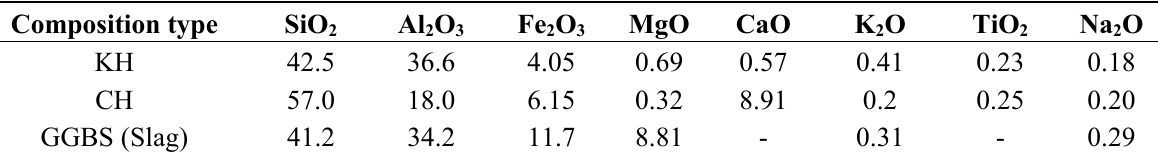
Table 1. Chemical composition of Hwangtoh.